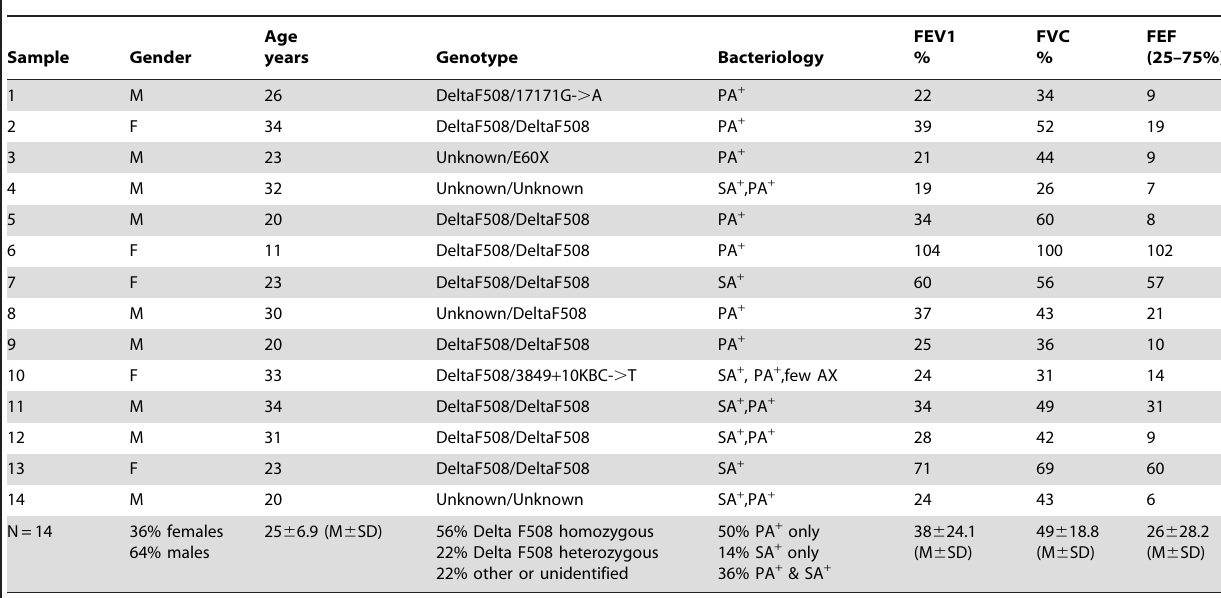
Table 1. Clinical Data of CF